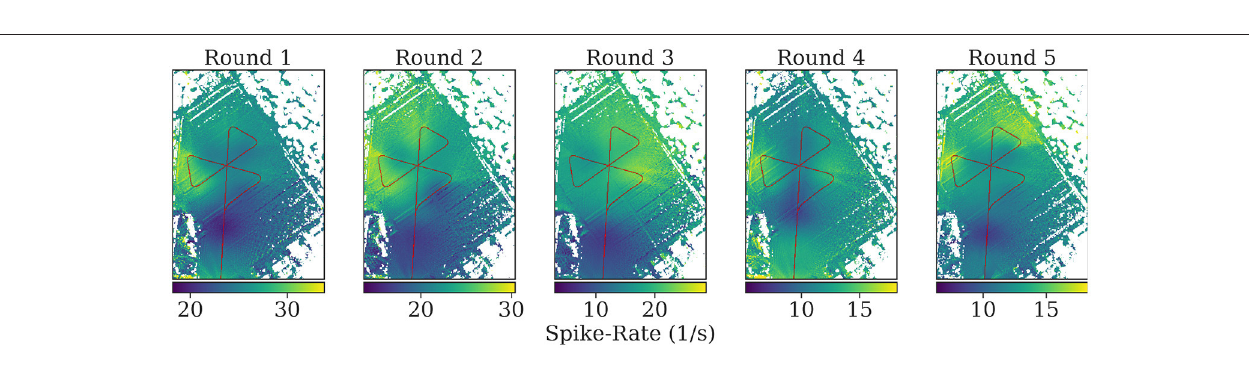
FIGURE 12 | Mapping of the spike rates on the field of view of the individuals during flights. At each position, all pixels in the field of view of the bee on the map are assigned the corresponding spike rate value at that time. The mean is calculated of pixels with multiple assigned spike rate values during mapping. Turns were excluded to highlight spike activity during parts of the rounds without high angular velocity. See the Supplementary Material for the mapped spikes rates including